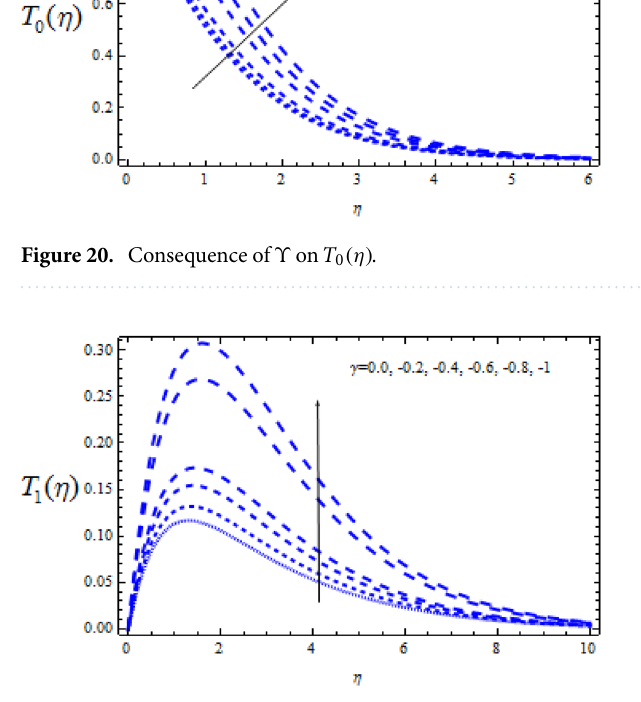
Figure 21. Consequence of ϒ on T 1 (η) .